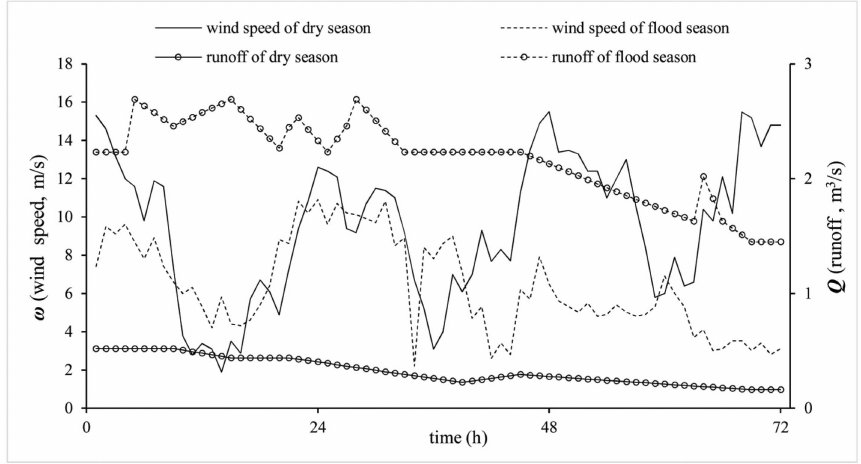
Figure 5. Wind speed and runoff measured at anemometer tower and hydrologic station, respectively, over 72-h-long